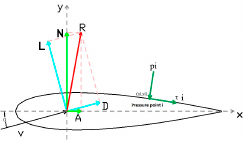
Figure 7. Aerodynamic forces on airfoil surface and their components.